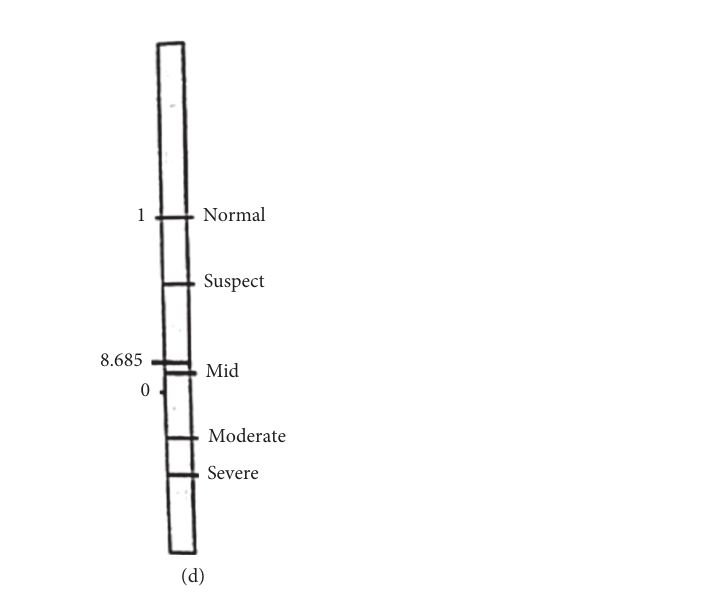
Figure 6: ORA signal of the right eye of a patient in group 3 (keratoconus). (a) Waveform and measurement values. (b) Waveform parameters deviation from mean. (c) Keratoconus match probabilities. (d) Keratoconus match index. Table 1: The age of the study groups in